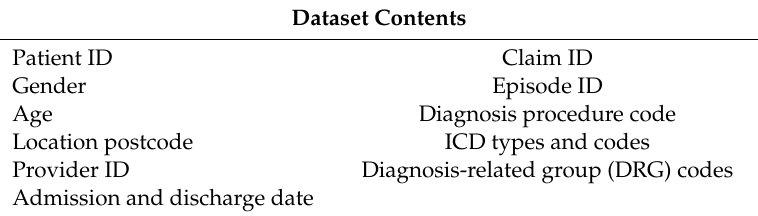
Table 1. Contents of the administrative data used in this study. ICD: International Classification of Diseases.